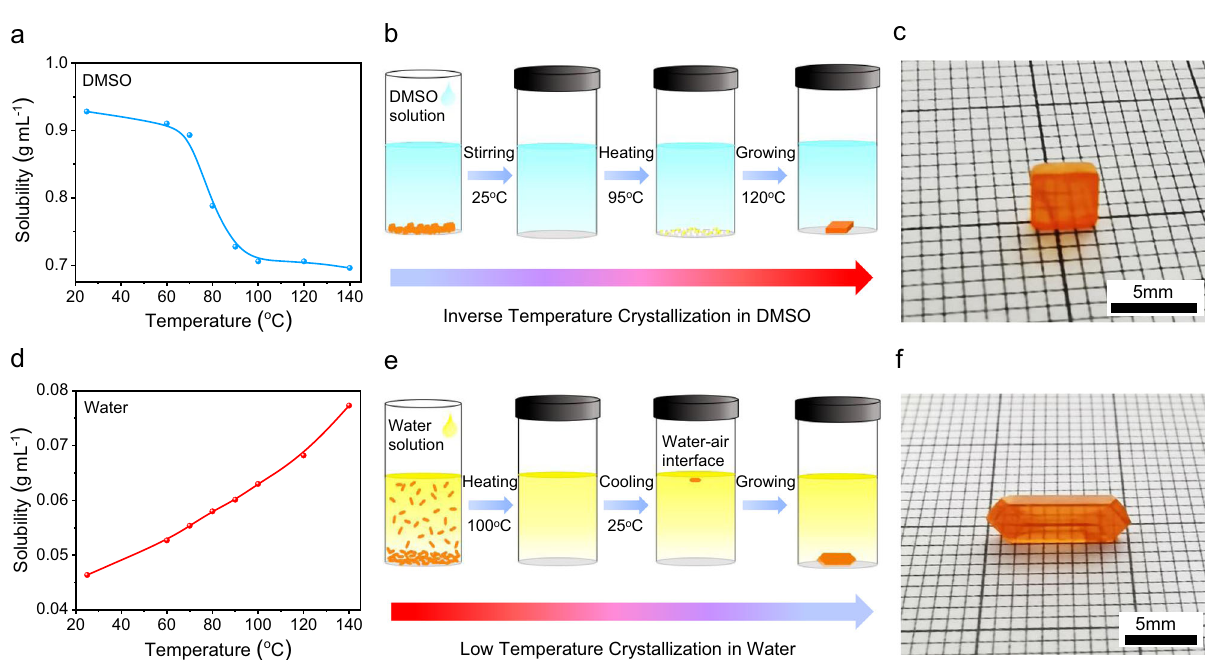
Fig. 1 Preparation of CsPbBr 3 single crystals. a Temperature-dependent solubility of CsPbBr 3 in DMSO. b Schematic illustration of the inverse- temperature crystallization in DMSO. c Optical photo of the as-prepared CsPbBr 3 SC. d Temperature-dependent solubility of CsPbBr 3 in water. e Schematic illustration of the low-temperature crystallization in water. f Optical photo of the as-prepared CsPbBr 3